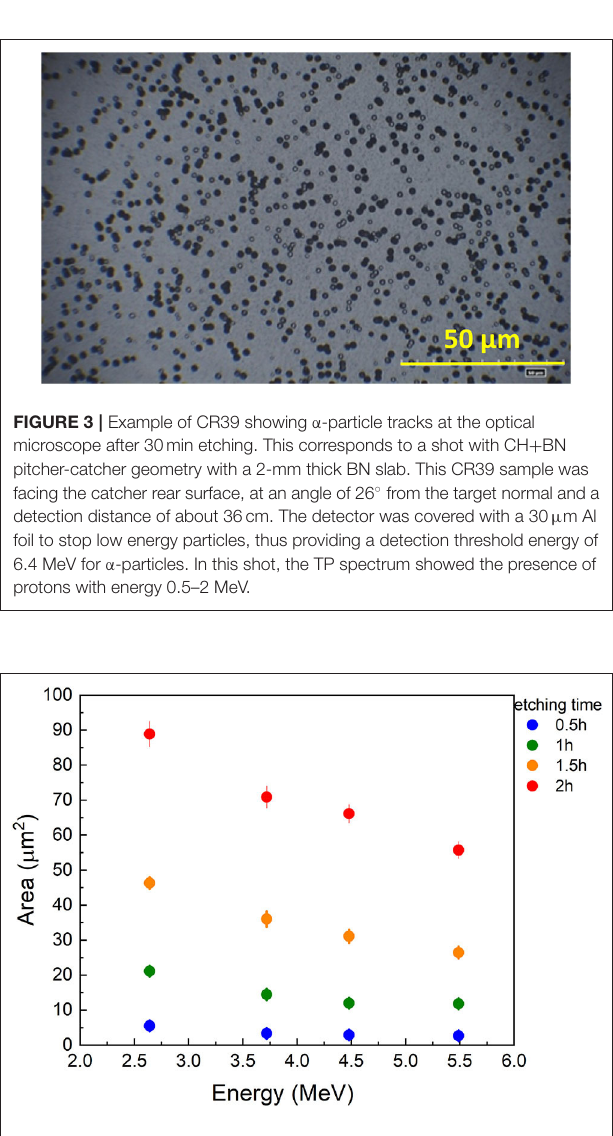
FIGURE 4 | Calibration curve for CR-39 etched using a KOH 6M solution at 70 ◦ C and using α -particles emitted by a 241 Am thin